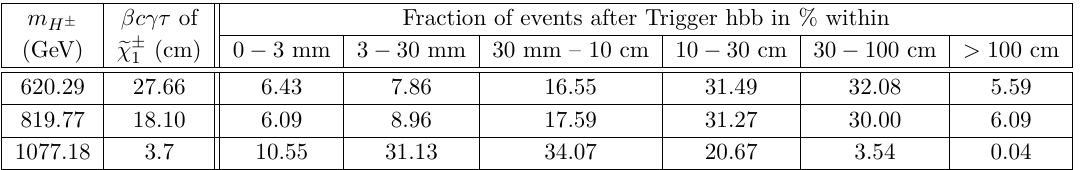
Table 33. The fractional number of events which decay at different parts inside tracker for the 4